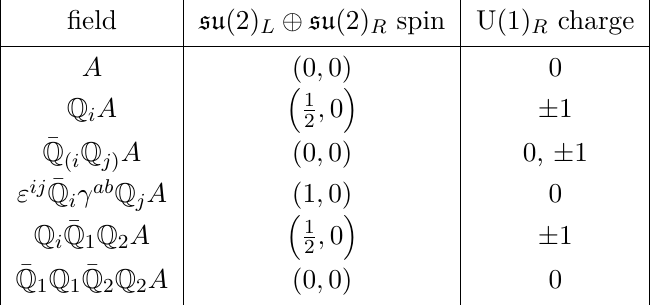
) are counted with multiplicity L , j R